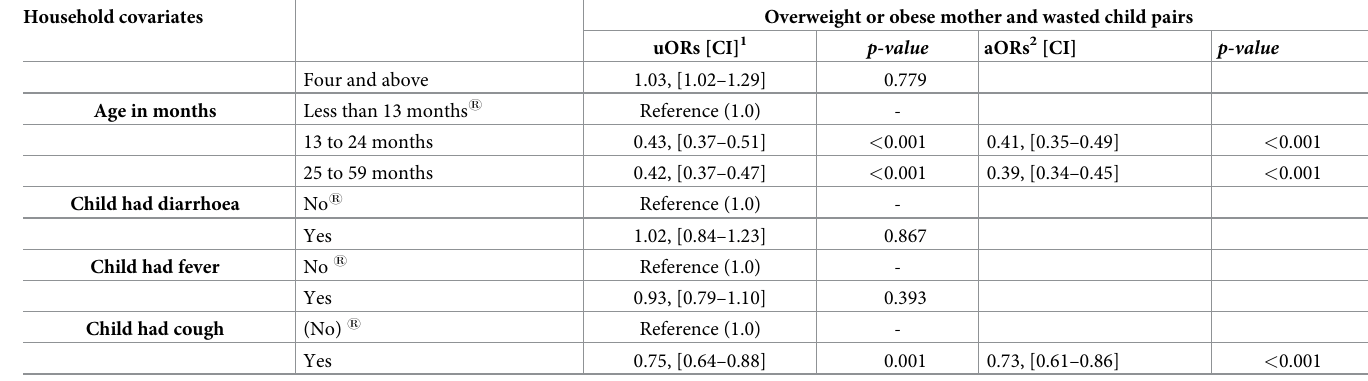
1 .Odds ratios and confidence interval at 5% significance level of bivariate regression models 2 . Odds ratios in multivariable model after adjusting for the variables which were significant at 5% level in bivariate